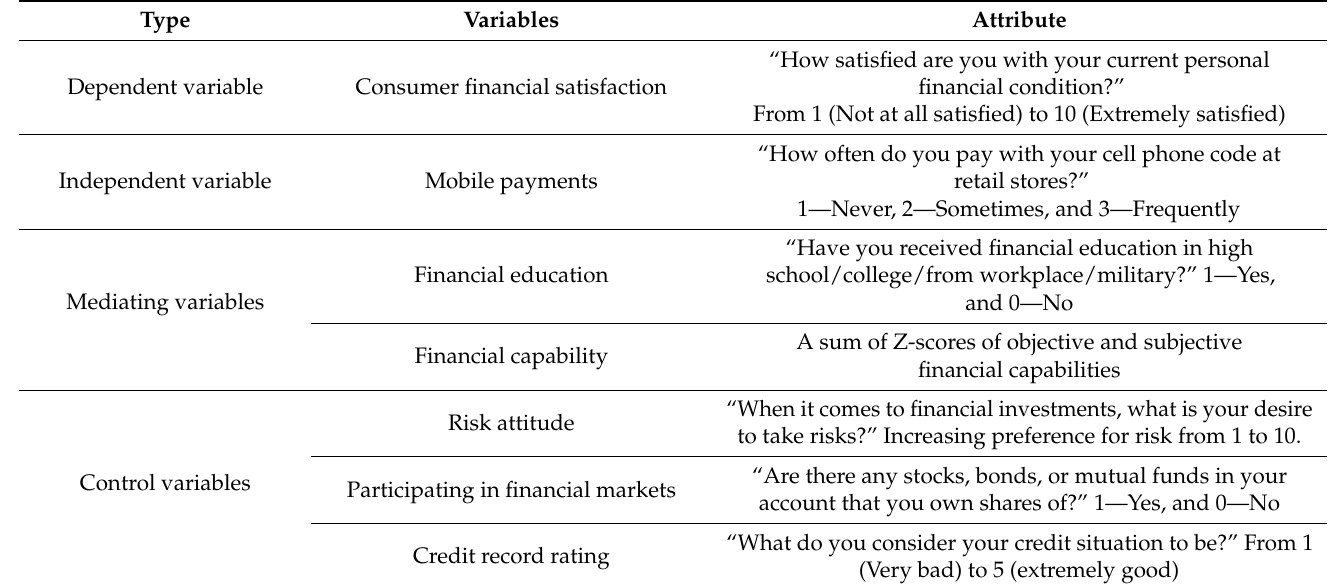
Table 1. Variable